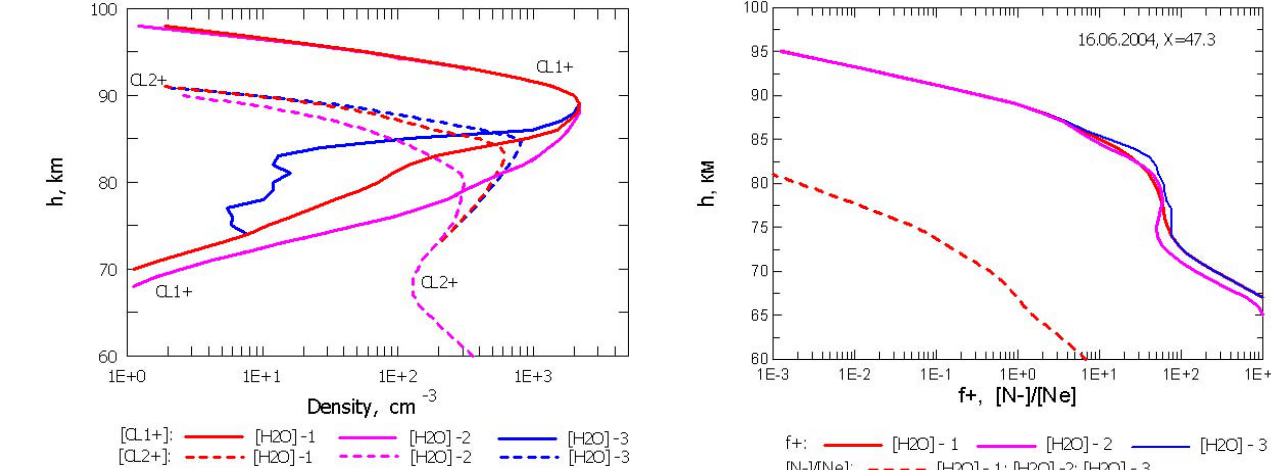
Fig. 5b. Number density profiles for the Cl + cluster families for 16 June 2004 at 12:00UT, with a solar zenith angle of 47.3 ◦ and calculated for the H 2 O-1, H 2 O-2 and H 2 O-3 profiles.